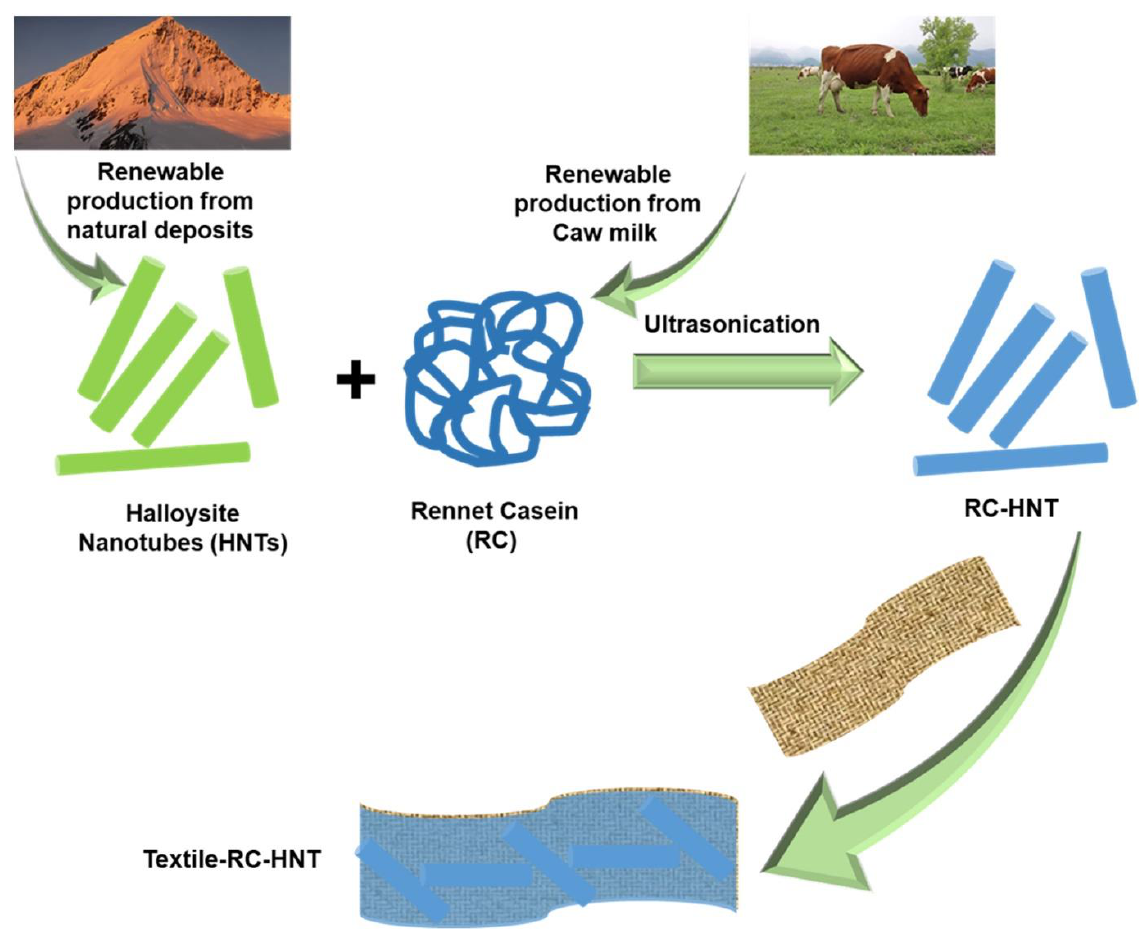
Figure 2. Schematic diagram representing the green synthesis of renewable textile fabrics coatings and their application on textile fabrics, reproduced with permission [13]. Copyright 2022, Elsevier.